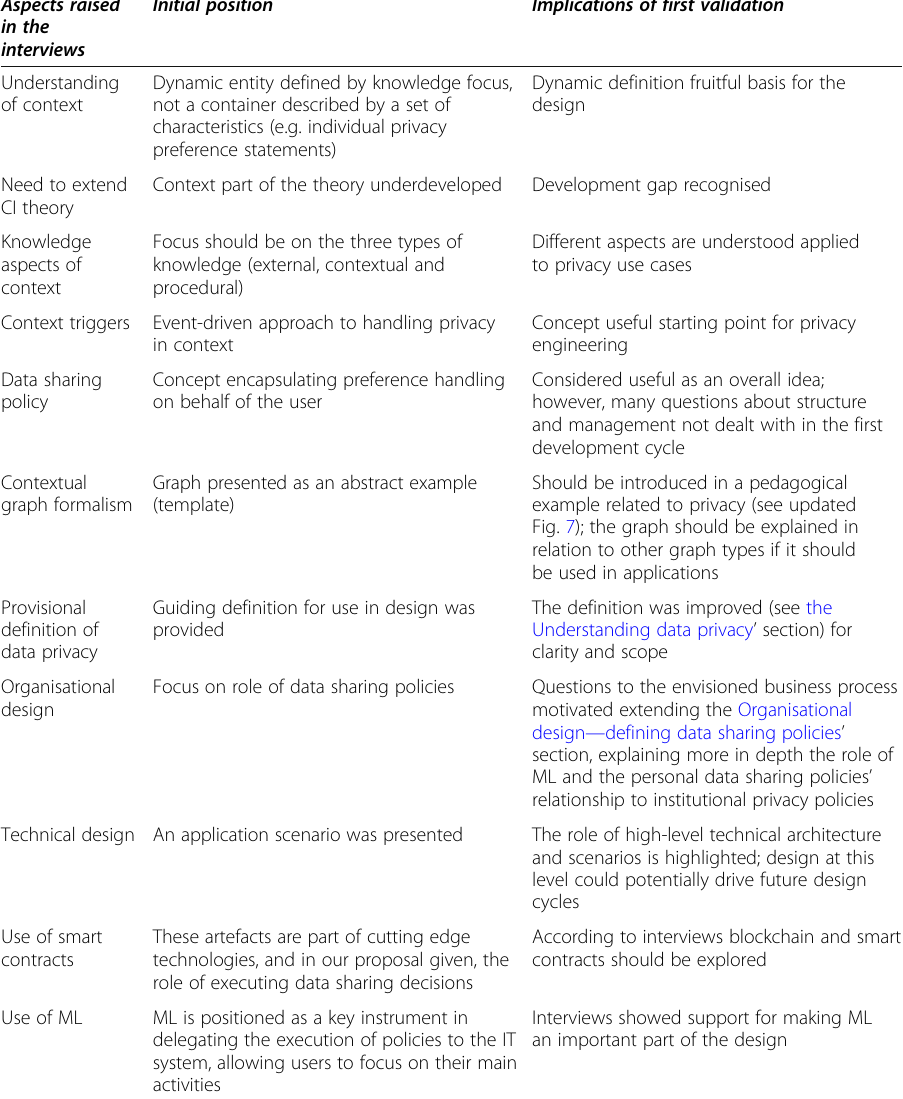
Table 1 Summary of first validation by aspect Aspects raised in